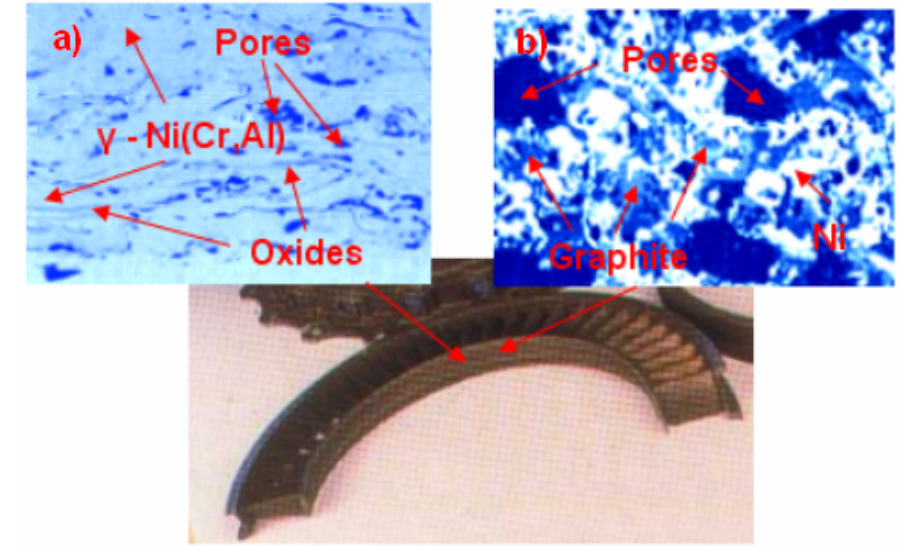
Figure 1 – Part of the focusing device of IV – IX degrees of the compressor and the microstructures of the system of the NiCrAl / Ni-25% graphite sealing